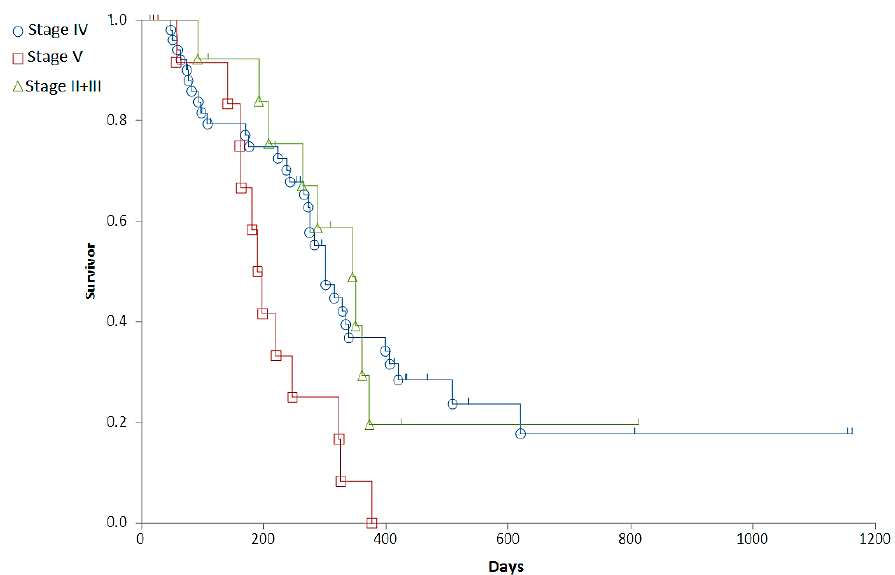
Figure 2. Representation of the relapse free period (RFP) of dogs with different stages on survival